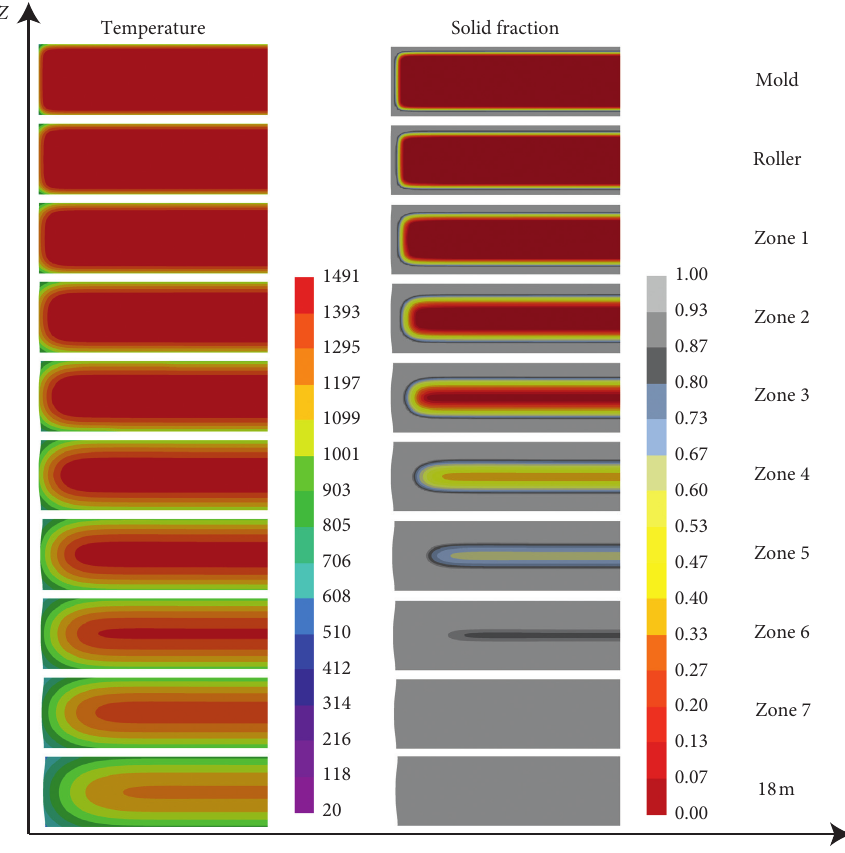
Figure 6: Cloud diagram of temperature field and solid fraction of the casting slab at cross section.